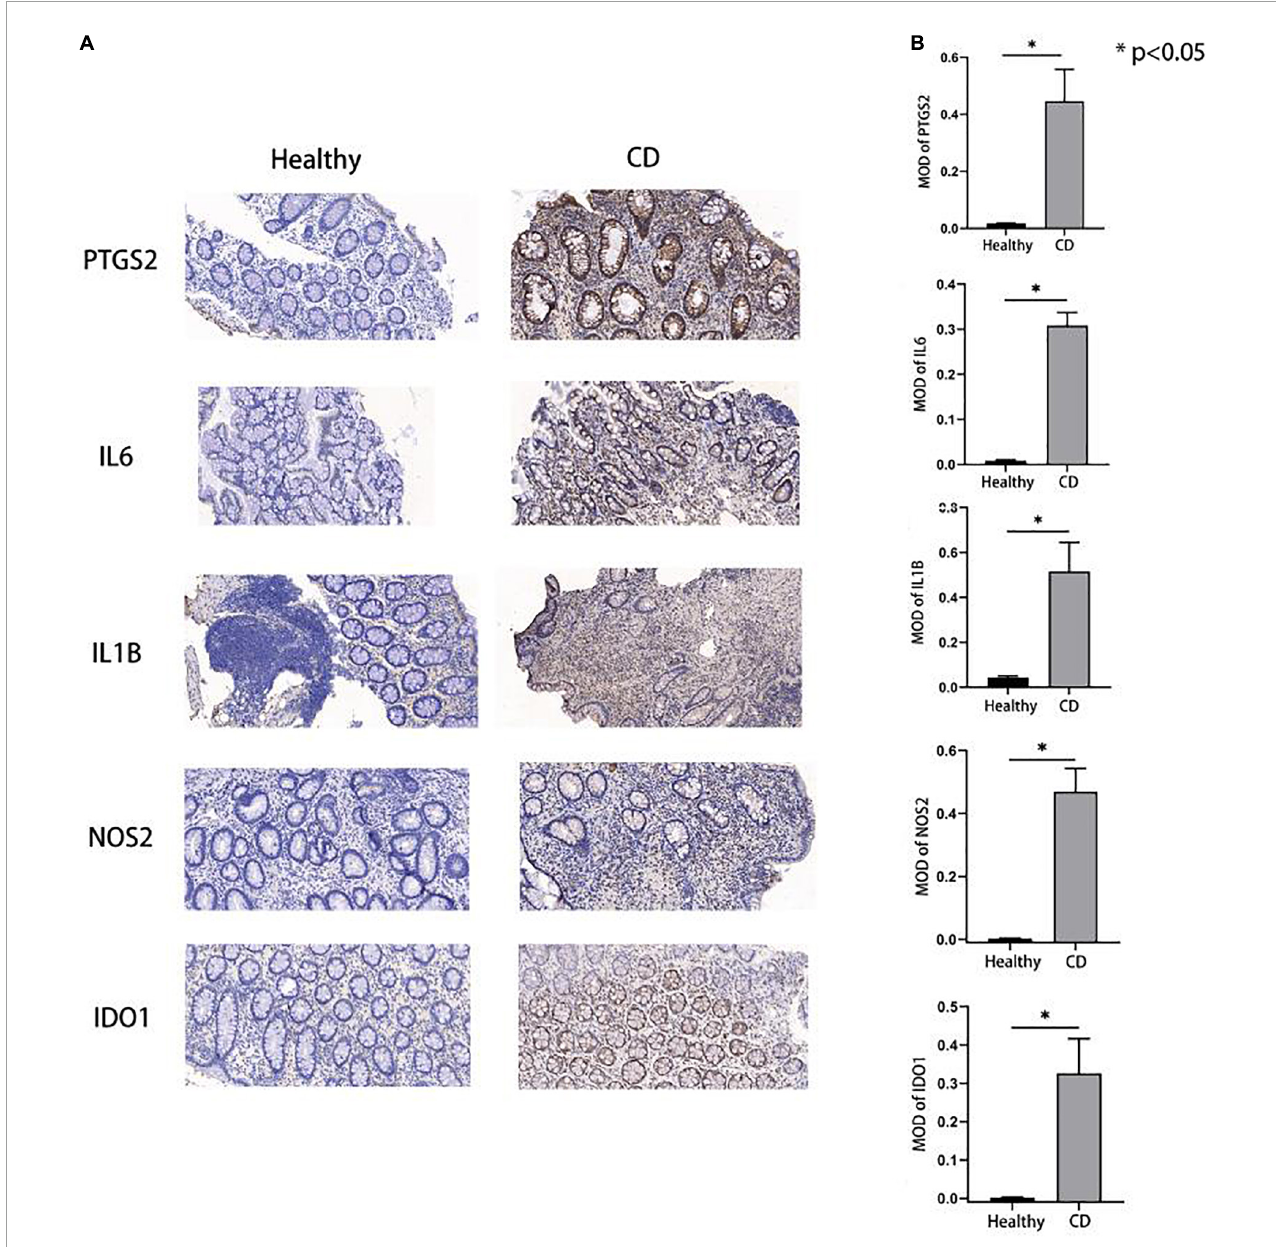
FIGURE6 Expression of hub genes in Crohn’s disease and control group. (A,B) Immunohistochemical results showed that the hub gene expression in the disease group was higher than that in the control group, and the p -values were all less than 0.05, which was statistically